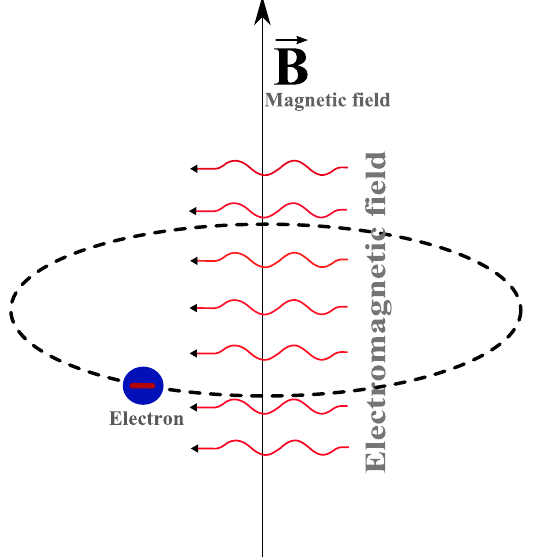
Figure 1. Interaction of an electromagnetic field with an electron in a magnetic